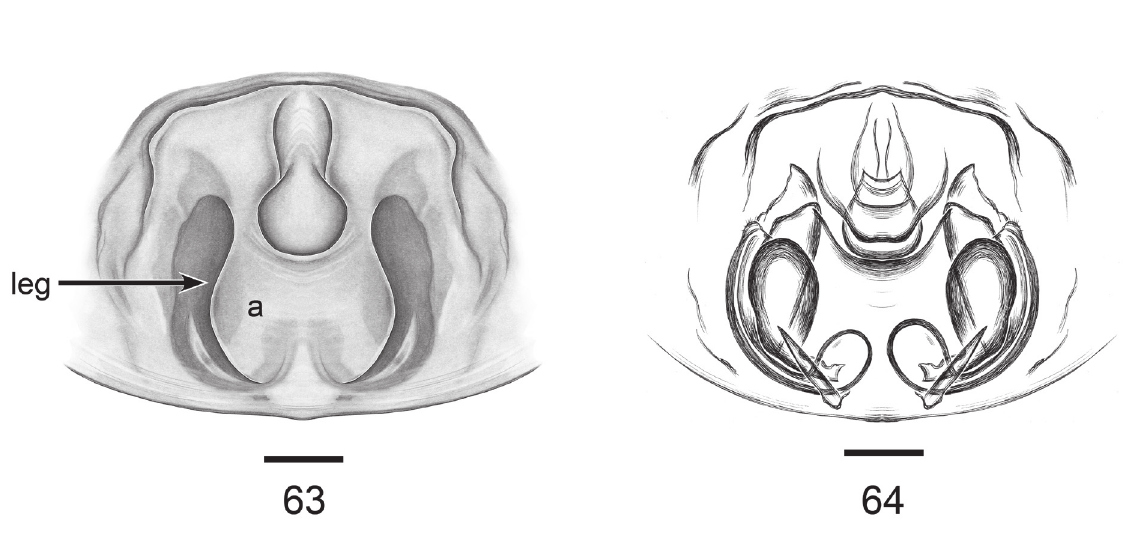
Figs 63–64. Patrera suni sp. nov. 63 . ♀, epigynum, ventral view. 64 . ♀, internal genitalia, dorsal view. Scale bars: 0.1